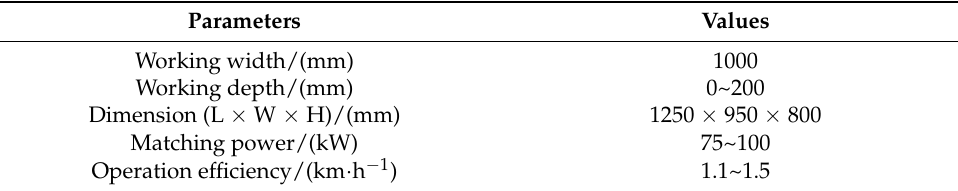
Figure 2. Structure parameters of counter-rotating excavation device. Table 1. Discrete element contact